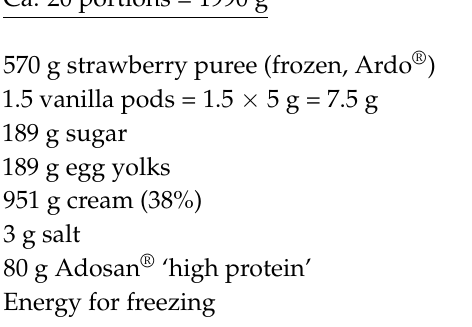
Procedure: Mix thawed, but cool fruit puree with the other ingredients in a mixing bowl. Carefully add the whipped cream to this, fill it in plastic cups, and